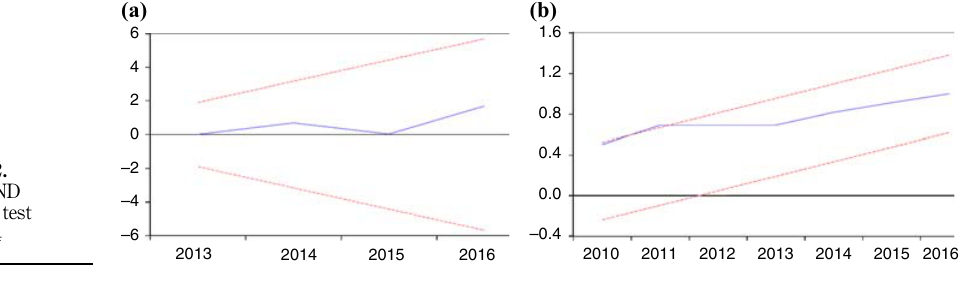
Figure A2. CUSUM AND CUSUMSQ test for Model 4